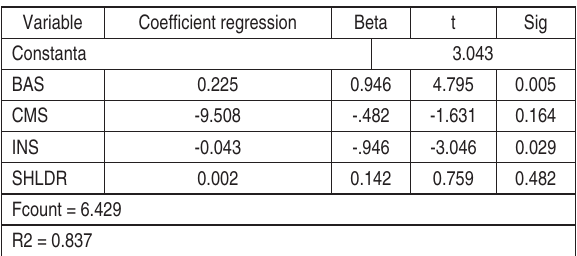
Table 4. Regression